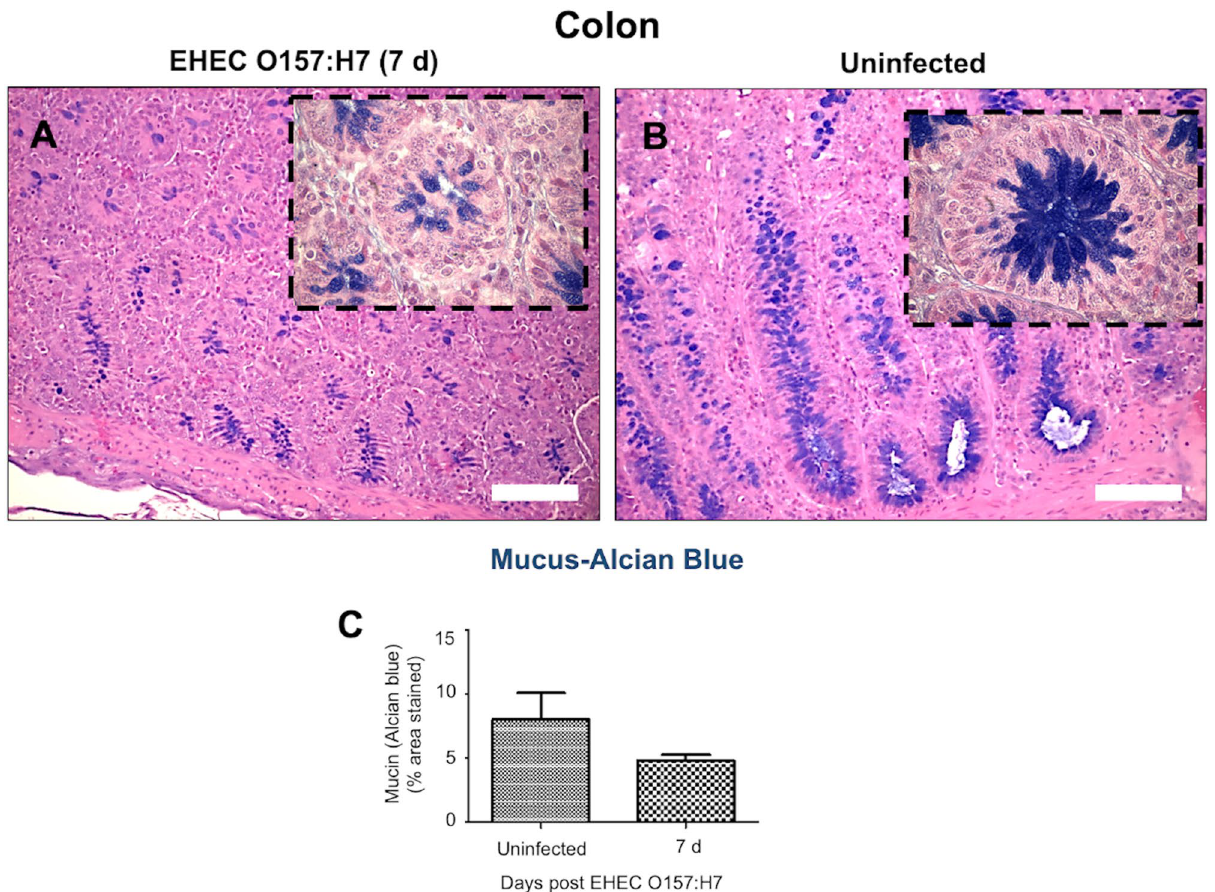
Figure 5. Microphotographs (alcian blue/hematoxylin stain) of goblet cells producing mucopolysaccharides and sialomucins (mucus) in ( A ) colons of calves challenged by EHEC O157: H7 (7 d post-challenge) and ( B ) colons of uninfected calves, and ( C ) their respective quantification. Bar = 100